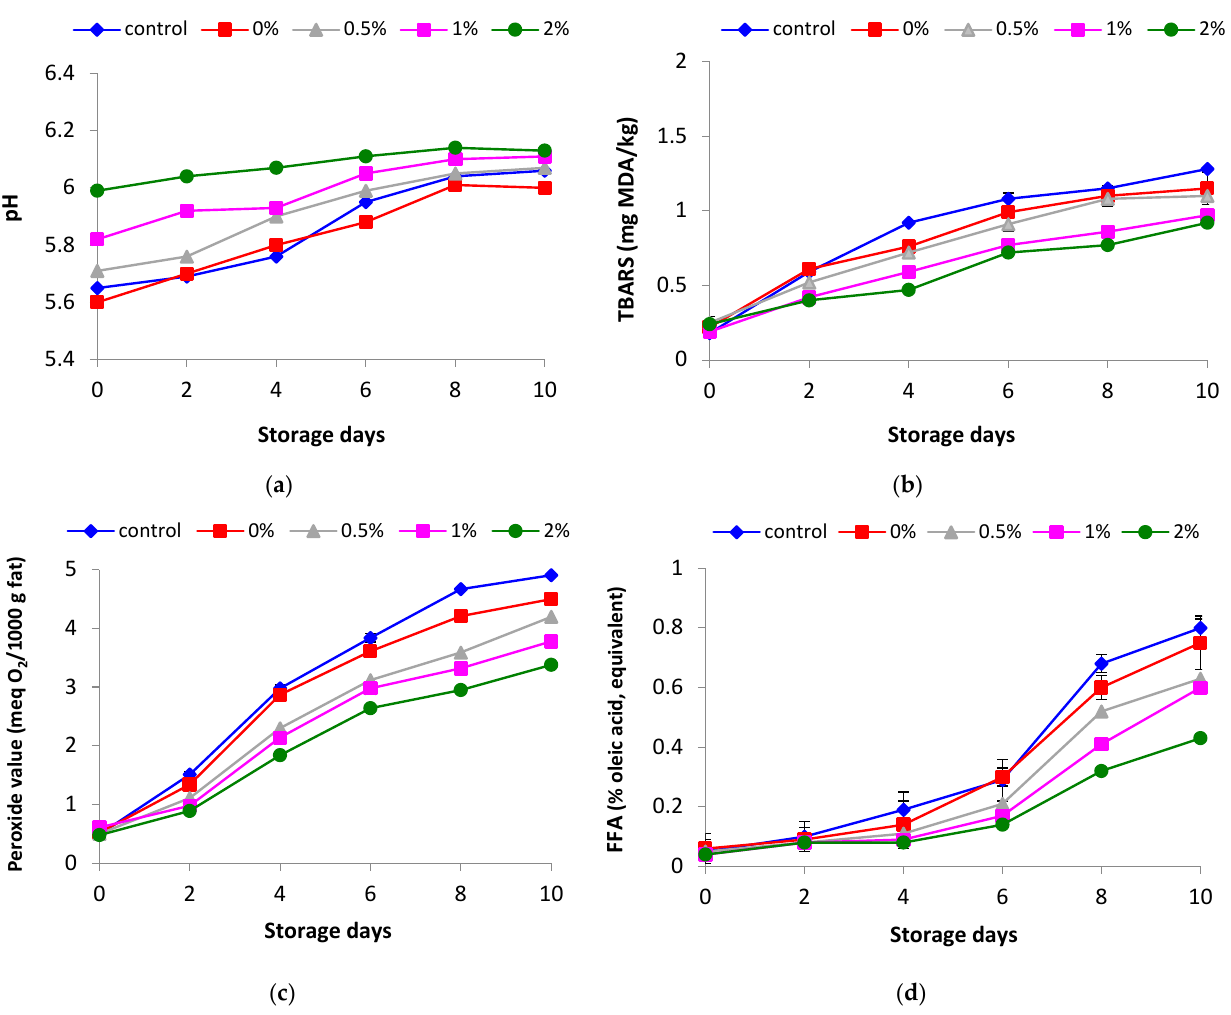
Figure 1. Effect of different concentrations of LMWCH (%) on pH ( a ), TBARS ( b ), peroxide ( c ), and free fatty acid ( d ) values in low-fat beef burger and control sample during 10 days of storage in the refrigerator (4 °C).